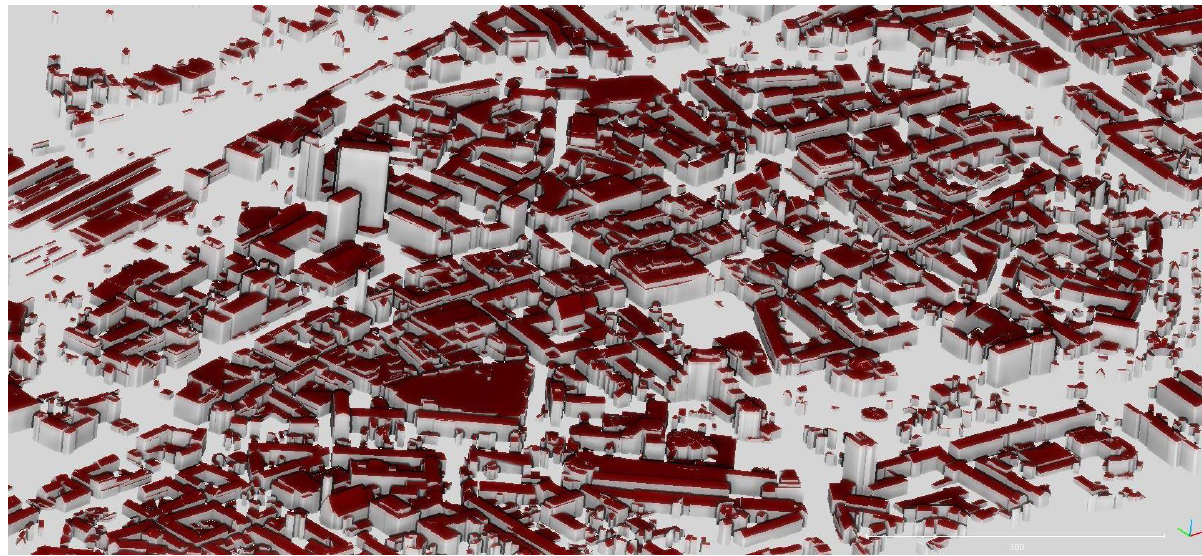
Figure 4: LOD2 building models (no roof overhanging) over Dortmund automatically generated from a dense point cloud derived from nadir & oblique imagery – ISPRS/EuroSDR benchmark, IGI PentaCam. some selected buildings, ground truth data in form of Airborne Laser Scanning (ALS) and Terrestrial Laser Scanning (TLS) point clouds as well as topographic and GNSS-based